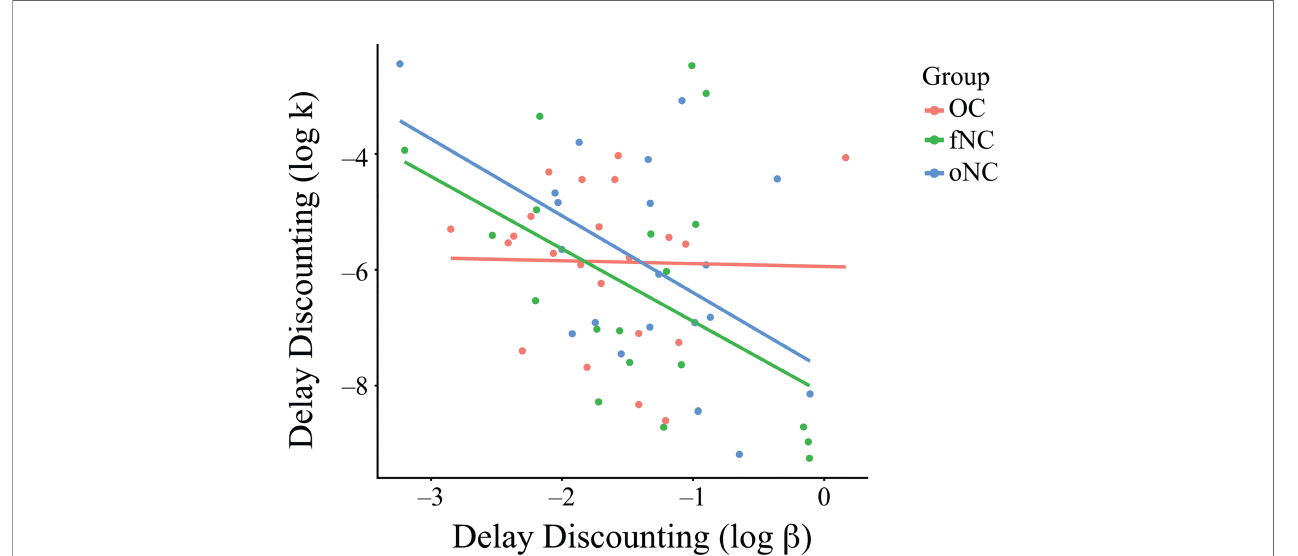
FIGURE 3 | Relationship between the parameters k and b of the delay discounting task per group. Correlation analyses showed signi fi cant correlations of k and b for the fNC ( r = -.48, p = .033) and oNC ( r = -.51, p = .021) groups, but not for the OC group ( r = -.02, p = .919; Figure 3 ). However, the correlation coef fi cients between groups did not differ signi fi cantly (fNC vs. OC, z = 1.51, p = .13; fNC vs. oNC, z = 0.12, p = .91; oNC vs. OC, z = 1.63, p = .1; Bonferroni-corrected at a = .017). Each dot represents an individual subject. OC, women using OCs; fNC, women in the early follicular phase; oNC, women during periovulatory phase.